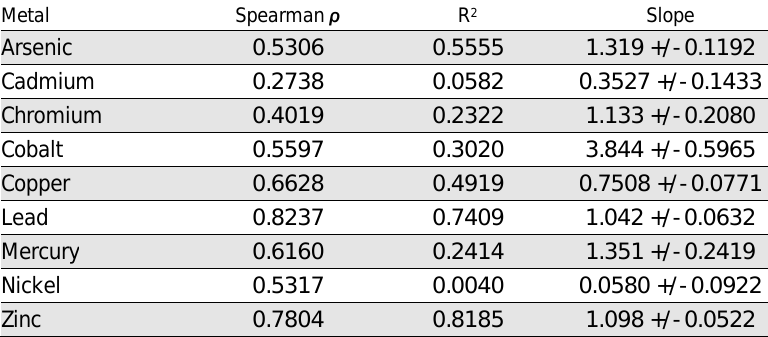
Table 4. Correlation and Linear Regression Results for Each Metal Between the Two Analytical Instruments